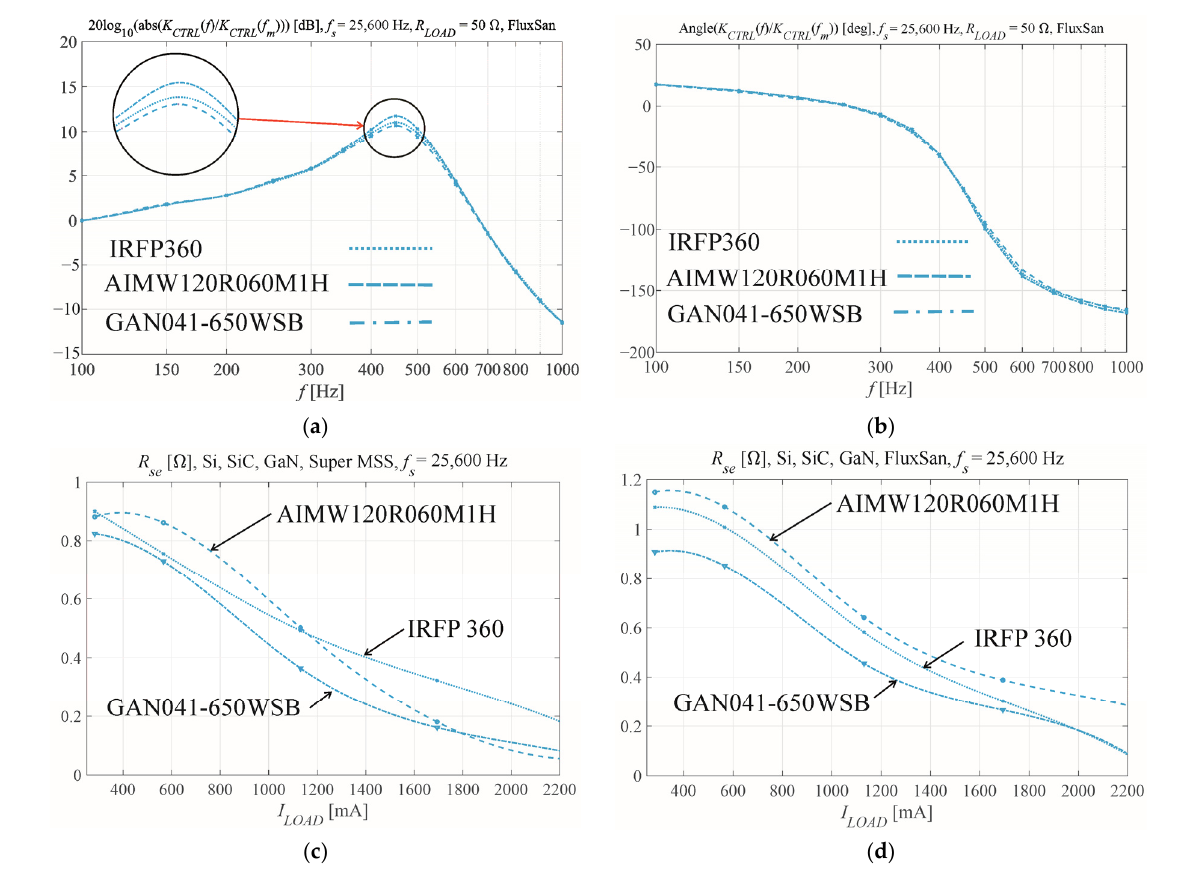
Figure 7. ( a ) Magnitude and ( b ) phase Bode plots of the VSI control function with a bridge composed of Si, SiC, and GaN transistors using a FluxSan coil core and a switching frequency f s of 25,600 Hz; ( c ) the calculated dynamic serial resistances R se for the Super MSS core with f s = 25,600 Hz; ( d ) calculated dynamic serial resistances R se for the FluxSan core with f s = 25,600 Hz.